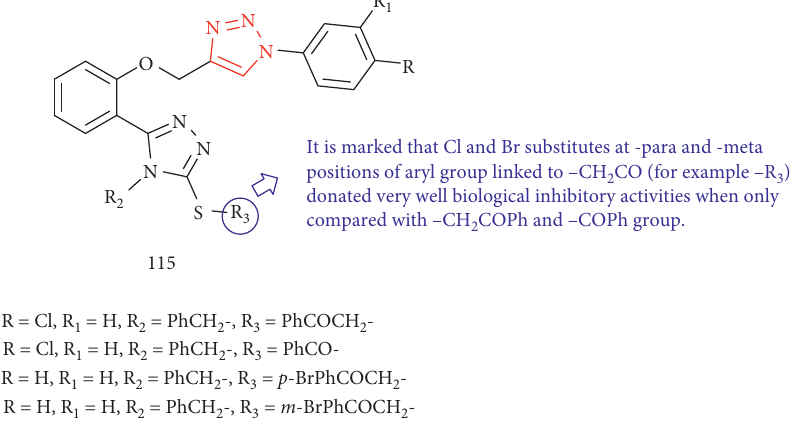
Figure 54: Structure of bis -(1,2,3- and 1,2,4)-triazole derivatives as potential antimicrobial and antifungal agents.